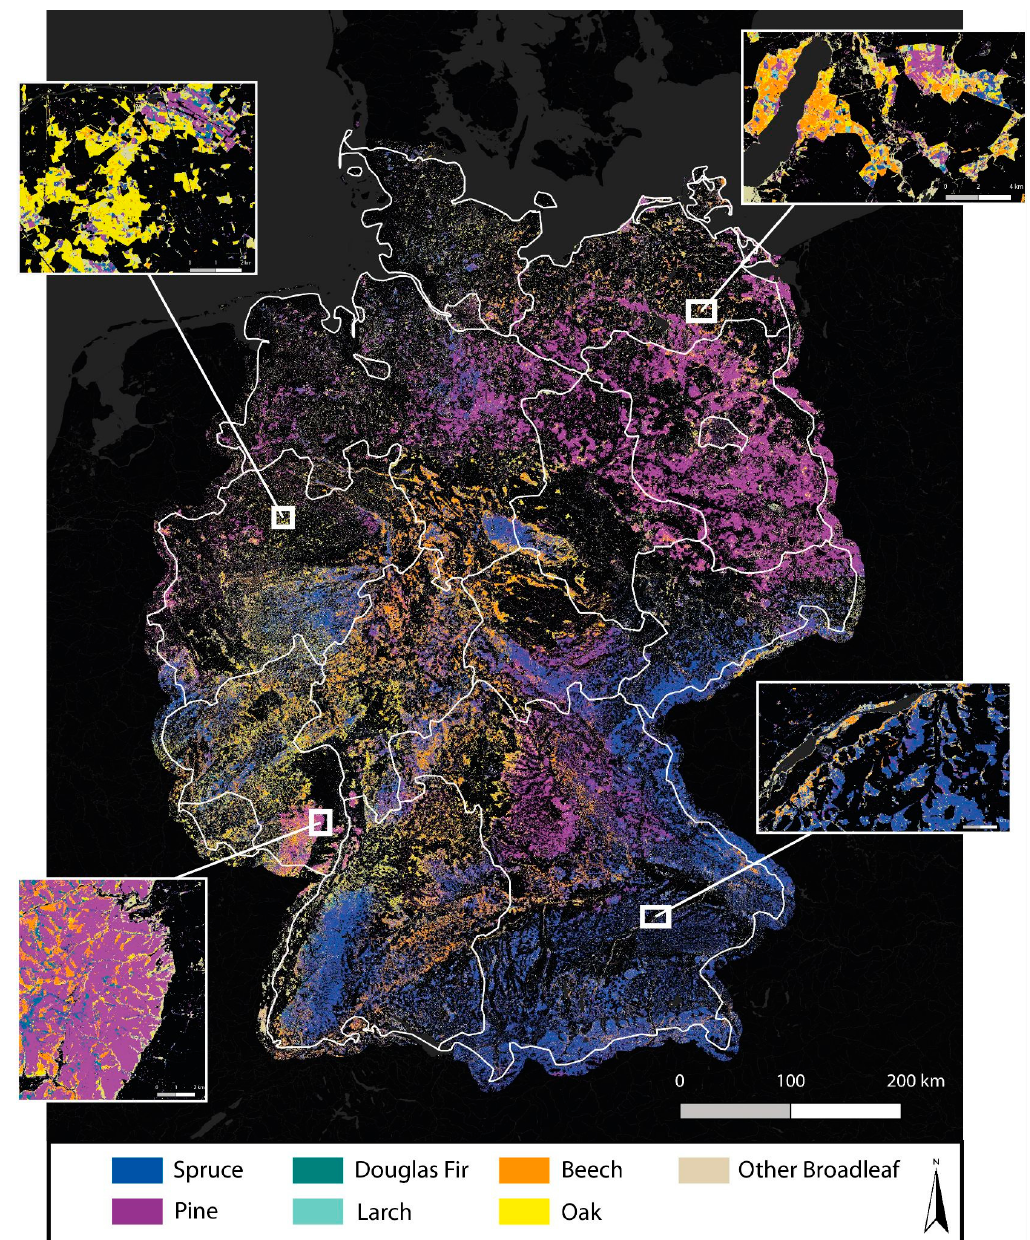
Figure 3. Dominant tree species map of Germany for the year 2017. The test of the model accuracy for the forest type classification (deciduous vs. non- deciduous) showed a weighted average F1-score of 0.95. The regional classifications of the deciduous tree species (including beech, oak, other broadleaved trees and larch) showed weighted average F1-scores between 0.77 and 0.91, while the classifications of non- deciduous tree species (spruce, pine and douglas fir) showed weighted average F1-scores between 0.85 and 0.94, depending on the regional model. Table 1 additionally lists species- dependent observed F1-score ranges, which range from reasonable to very good F1-scores. Douglas fir and larch are those species with the lowest F1-scores, while the highest scores were achieved for spruce, beech and pine. The lower F1-scores of the classes larch and douglas fir correspond with the lowest number of available samples in the reference data (Figure 1). The still reasonable F1-scores for these classes suggest that more reference data could support higher classification